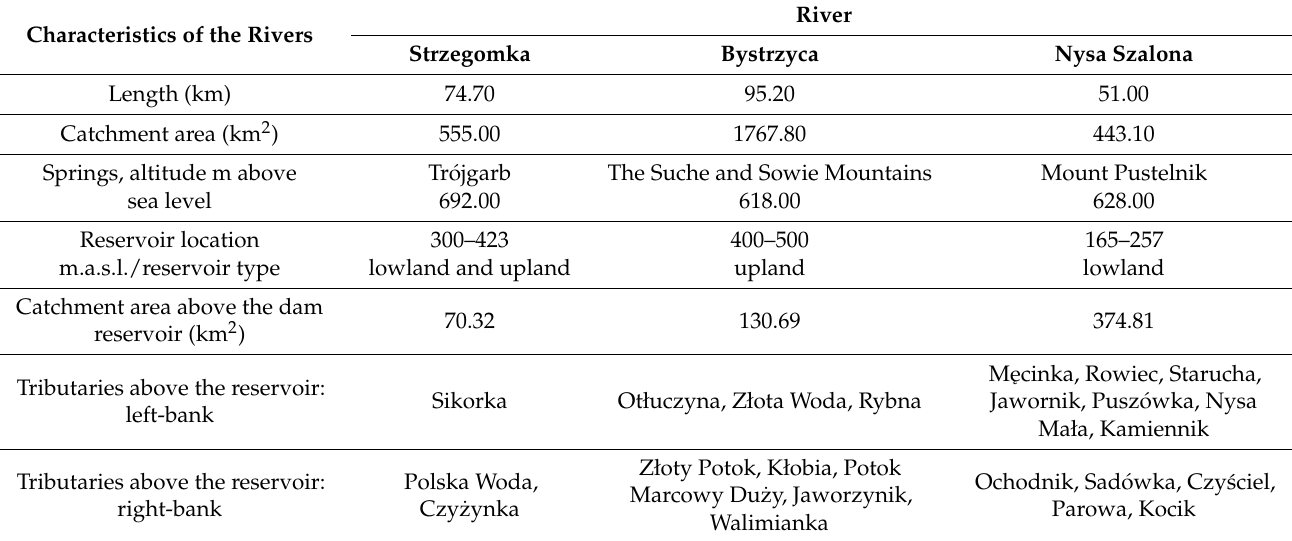
Table 1. Characteristics of the Strzegomka, Bystrzyca and Nysa Szalona rivers